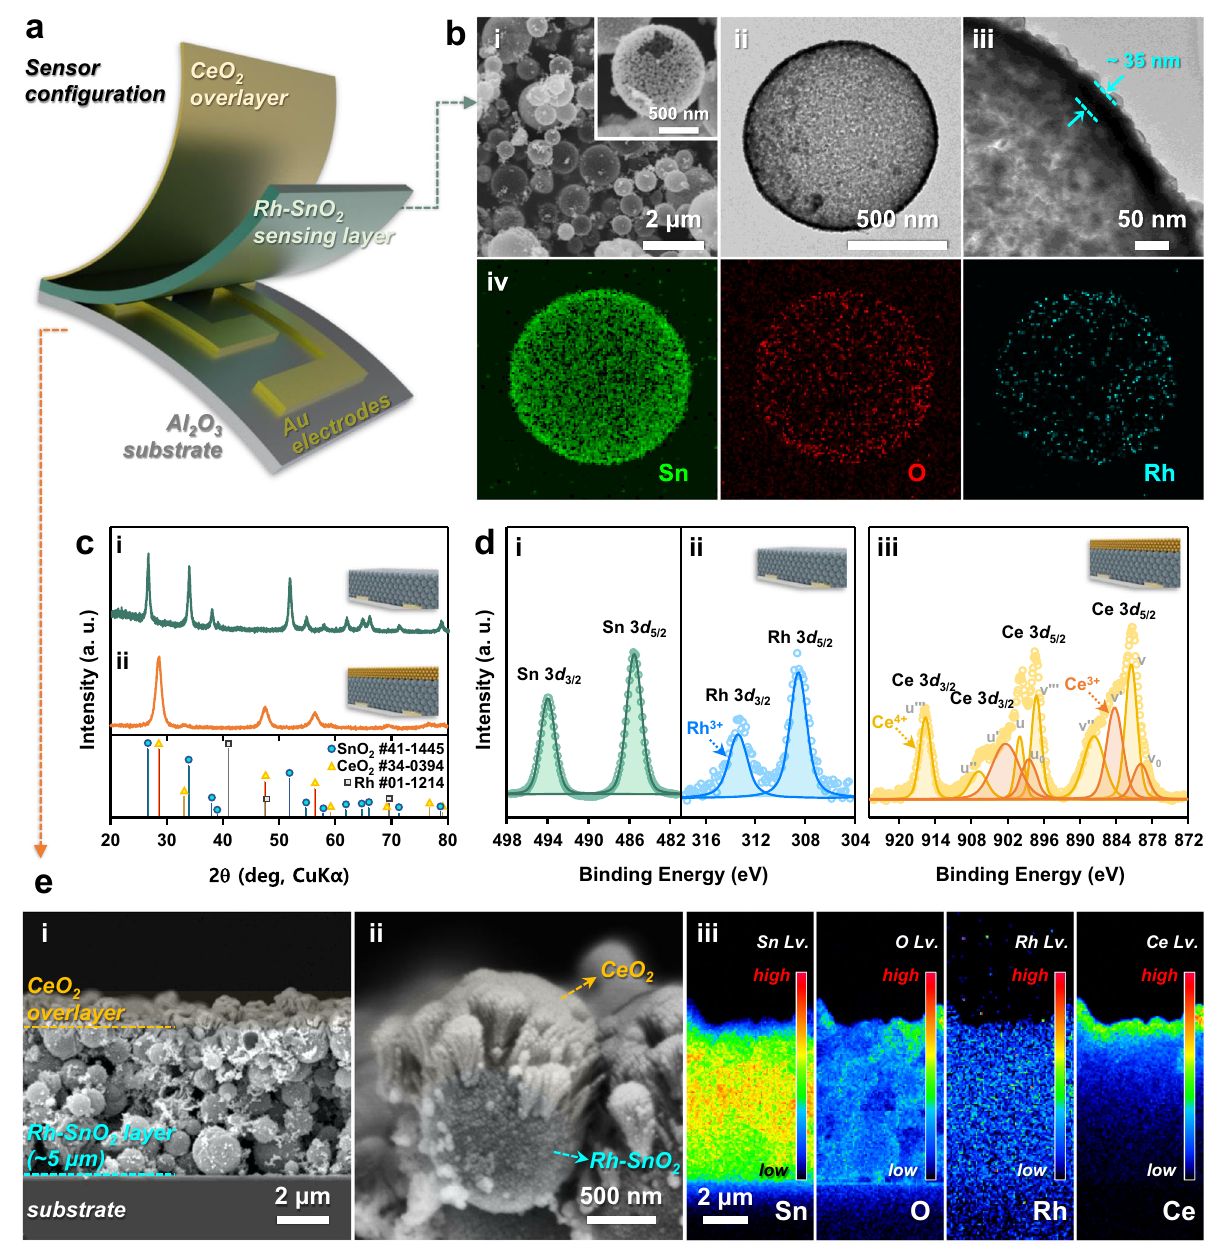
Fig. 2 | Morphology and phase characterizations of Rh – SnO 2 and CeO 2 / Rh – SnO 2 sensors. a Schematic of CeO 2 /Rh – SnO 2 bilayer sensor. b CharacterizationofCeO 2 /Rh – SnO 2 bilayersensor(i)SEM,(iiandiii)TEM,and(iv) EDS elemental (Sn, O, and Rh) mapping images of Rh – SnO 2 powders. c XRD